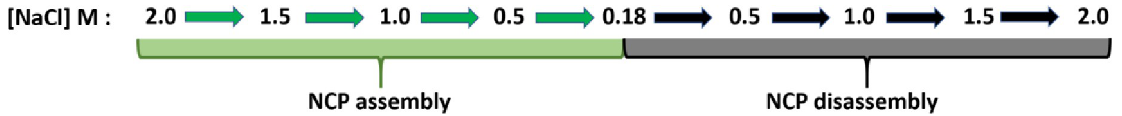
Fig 1. Outline of the PhAST experiments monitoring successive DNA structural changes induced during nucleosome assembly and disassembly by using stepwise decrease and increase of NaCl concentration.